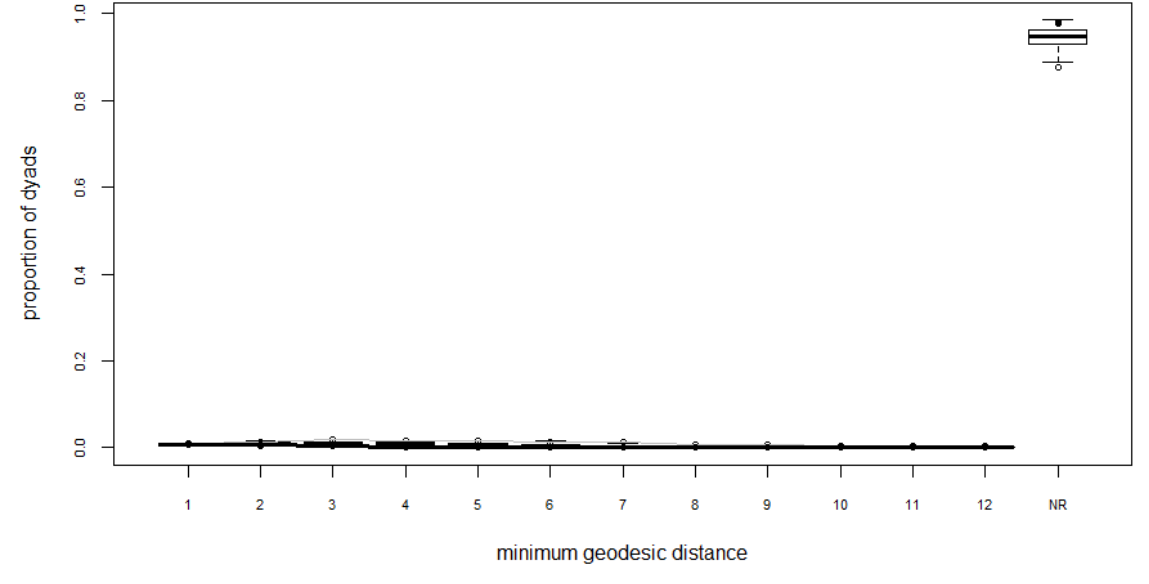
Figure A1.5. Goodness of Fit Diagnostics for Minimum Geodesic